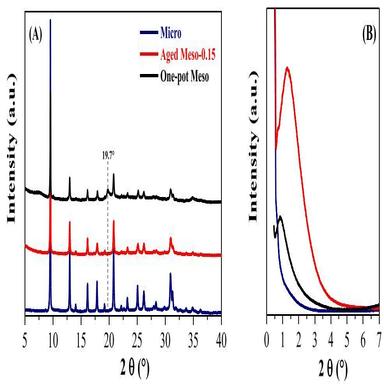
XRD patterns (A) wide- and (B) low-angle of conventional microporous SAPO-34 CHA-based zeolite and micro-mesoporous SAPO-34 CHA-based zeolites synthesized with different methods.